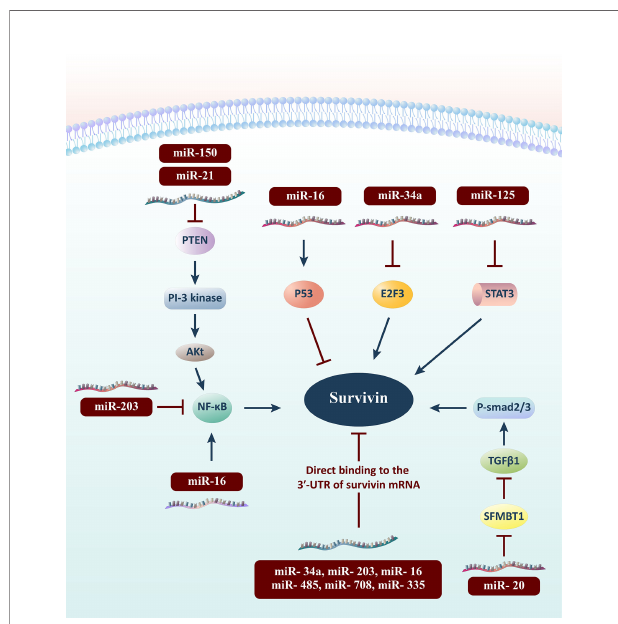
FIGURE 2 | The survivin-miRNA axis is depicted schematically. Several survivin-targeting miRNAs regulate survivin expression either directly by binding to the 3 ′ -UTR of survivin mRNA or indirectly by in fl uencing the pathways that alter survivin expression as a downstream target. For example, miR-16 inhibits the p53/survivin signaling pathway, resulting in survivin downregulation, while miR-21 and miR-150 downregulate PTEN. PTEN inhibits Akt via the PI3k axis, NF- k B-dependent survivin upregulation occurs. Similarly, miR-203 and miR-16 regulate survivin expression by interacting with NF- k B. MiR-20 is another well- established survivin-targeting miRNA that inhibits SFMBT1 and regulates the TGF- b 1/Survivin pathway. Moreover, miR-125 and miR-34a indirectly regulate survivin expression through interaction with STAT3 and E2F3, respectively. Conversely, miR-34a, miR-203, miR-16, miR-708, miR-485, and miR-335 speci fi cally target the 3 ’ UTR of survivin mRNA and hence downregulate survivin expression. PTEN, Phosphatase and tensin homolog; Akt, Protein kinase B; NF- k B, Nuclear factor-kappa B; TGF- b , Transforming growth factor-beta; E2F3, Transcription Factor 3; STAT3, signal transducer and activator of transcription 3; 3 ′ -UTRs, 3 ′ -untranslated